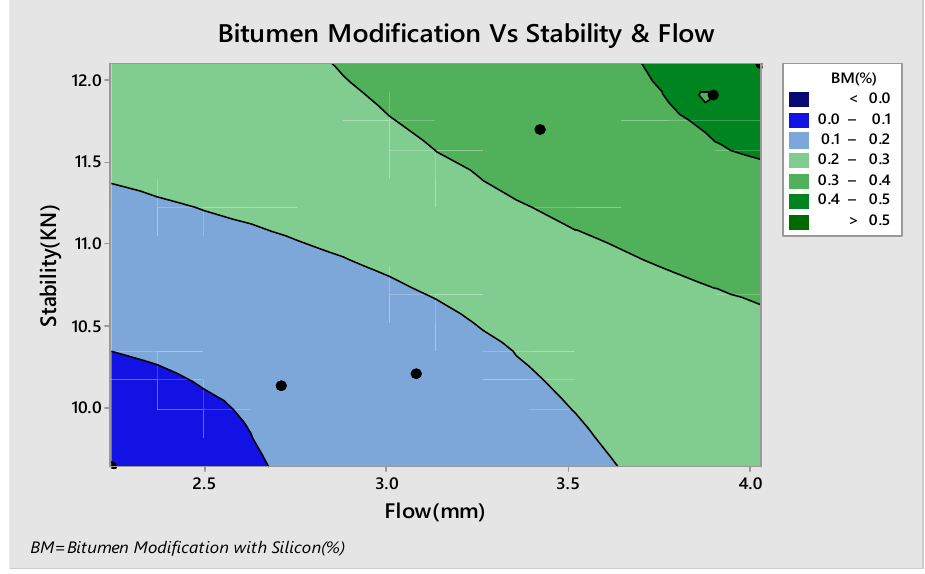
Figure 3. Comparative performance analysis of bitumen modification vs stability (KN) and flow (mm) .